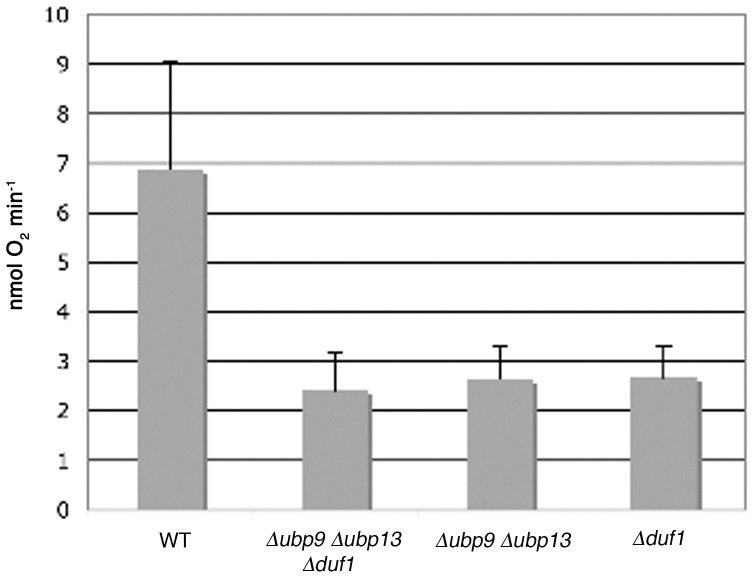
Δubp9 Δubp13, Δduf1 and Δubp9Δubp13Δduf1 cells display defective respiration.Cells grown on galactose at 37°C to the exponential phase, were diluted in potassium buffer pH 7.2 and placed for a few hours at 37°C. Respiratory growth was then measured on entire cells, after the addition of 0.2% galactose, over a period of 7 min, with a Clark-Type electrode, as previously described [51].